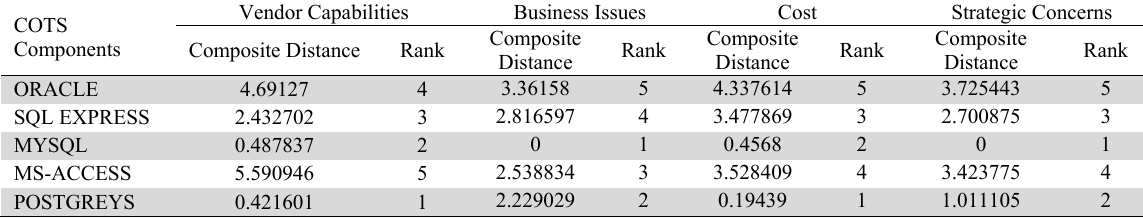
Overall Ranking of DBMS COTS Component using FDBA COTS